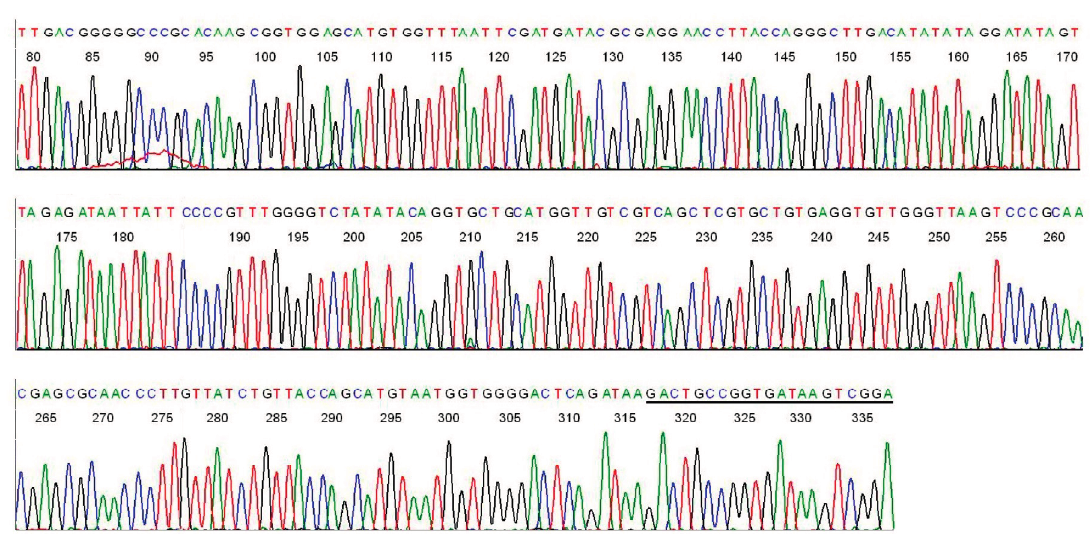
Figure 5. Base-calling sequencing electropherogram of an M1/M2 same-nested PCR amplicon showing part of a 357-bp segment of the 16S rDNA of B. burgdorferi (Figure 1, lane P). M1 was the sequencing primer. The M2 binding site is